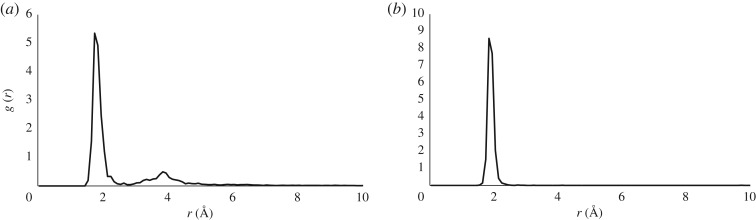
RDF for (a) Al–Opept and (b) Al–Owat distances in Al-EAAAD.